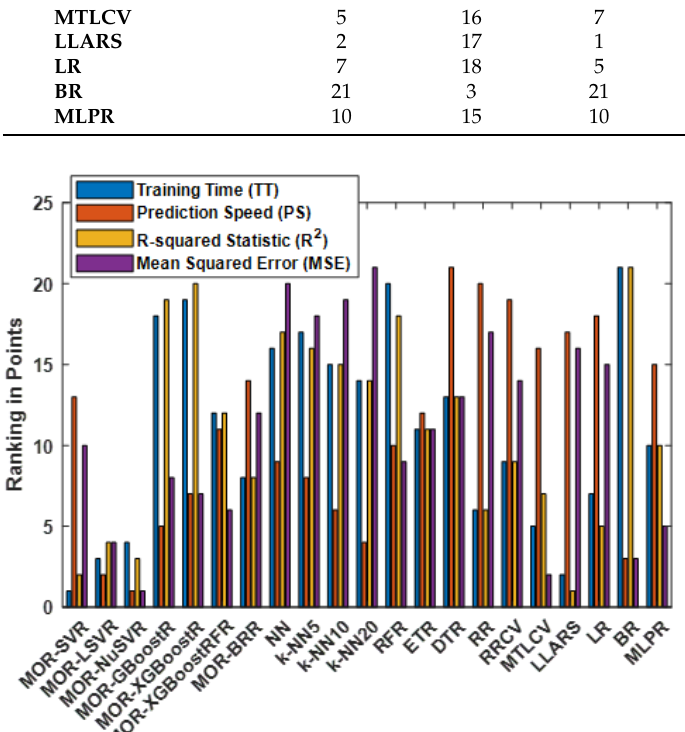
Figure 11. Ranking (in points) of all methods using the average values of their performance metrics (i.e., TT , PS , R 2 , and MSE ) over 50 statistical runs for the first